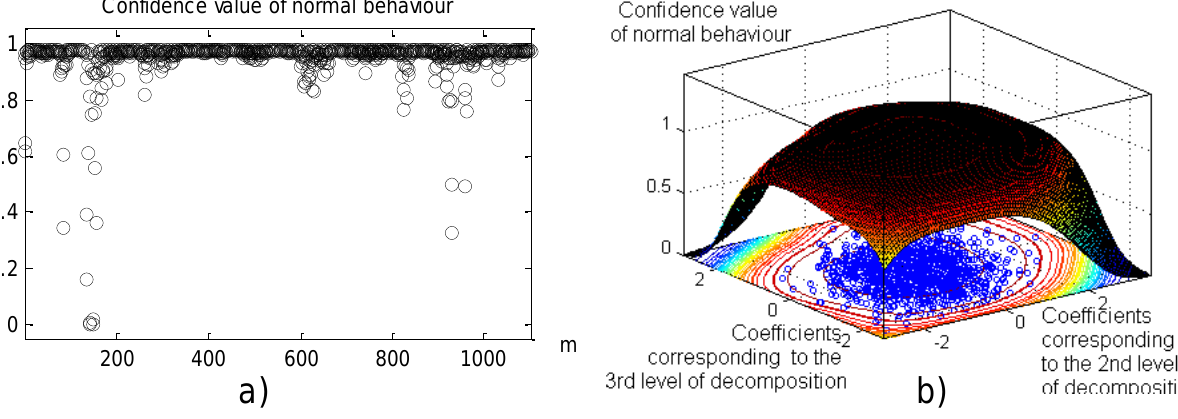
Figure 19. Retaining dam leakage detection: 6th iteration of heat-up. ( a ) The calculated confidence values: values close to 1 are related to normal behaviour, close to 0 mean anomaly. ( b ) 3D view of the constructed Neural